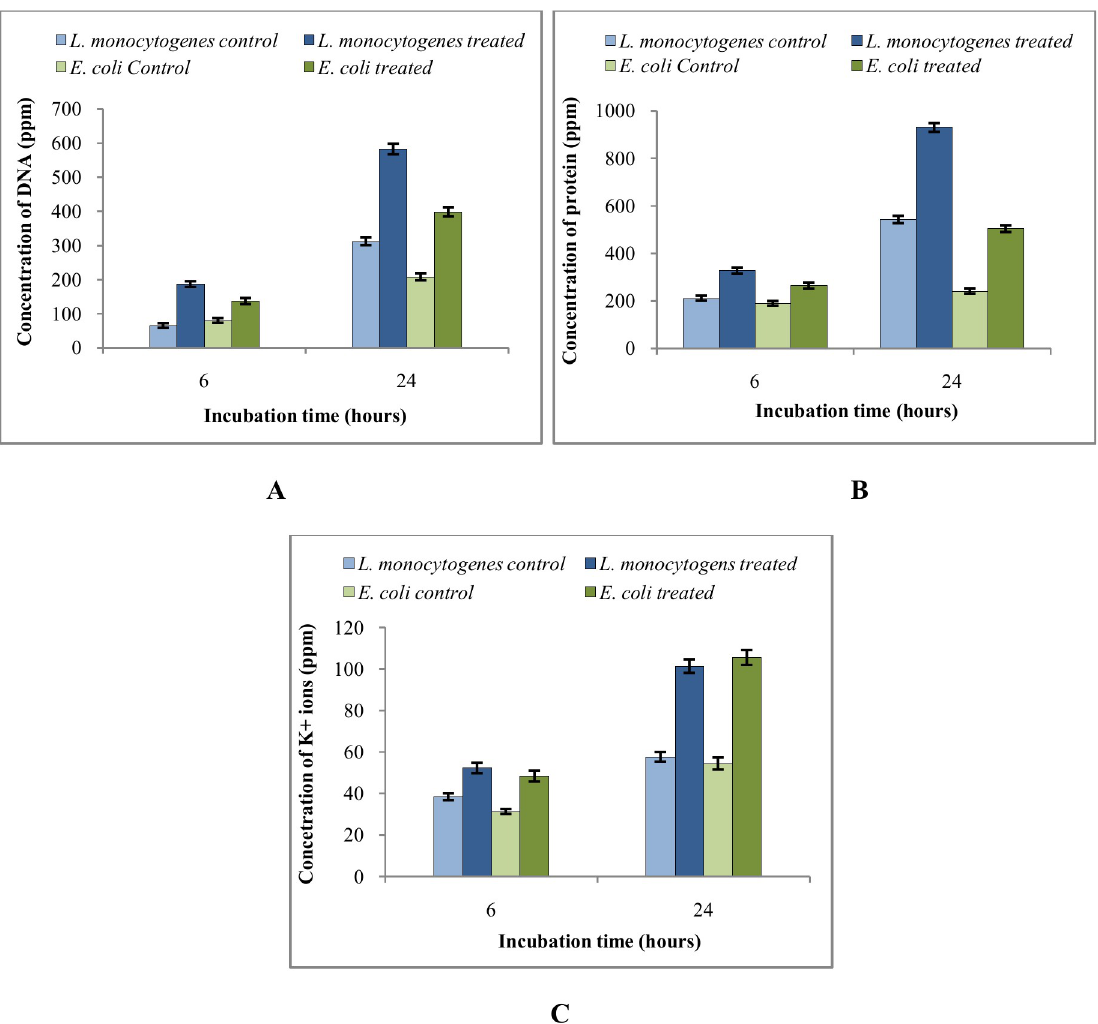
Fig 5. Release of intracellular materials from pathogenic bacterial cells upon treatment with EA fraction of AE1: A- release of DNA; B- release of protein; C-leakage of K + ion.